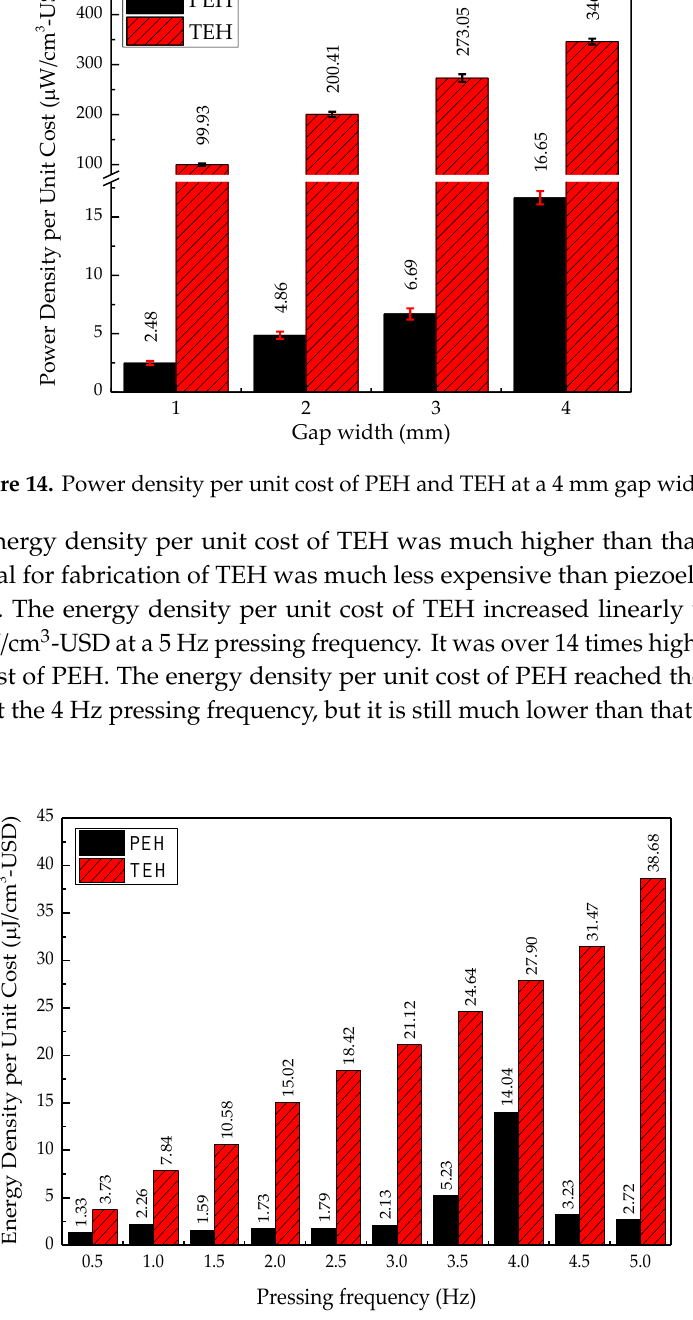
Figure 15. Energy density per unit cost of PEH and TEH at a 4 mm gap width.